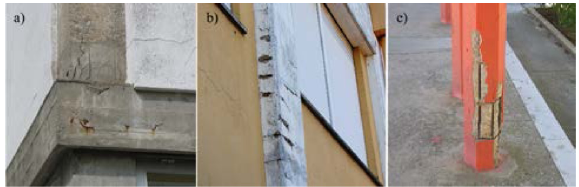
Fig. 7. Illustration of severity levels: a) level 1 – exposed concrete beam; b) level 2 – painted concrete column; c) level